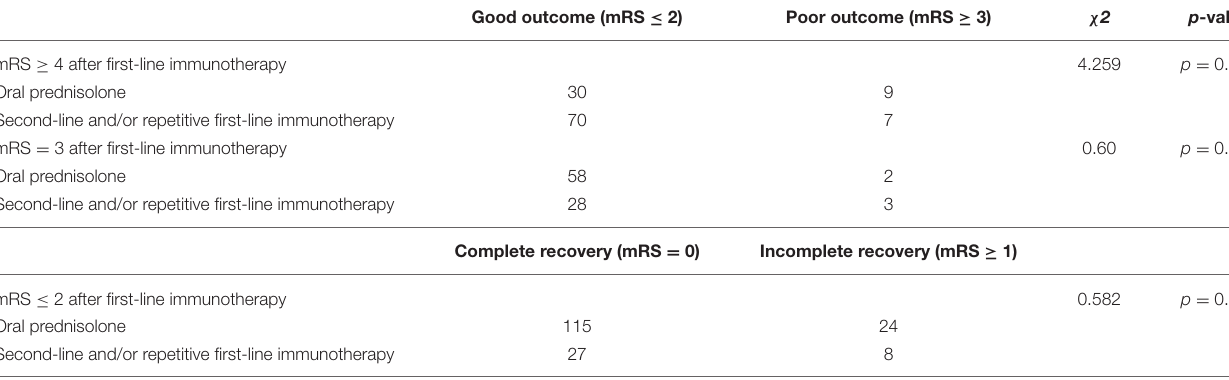
TABLE 3 | Comparison of effects of oral prednisolone and other treatments on patient outcome.